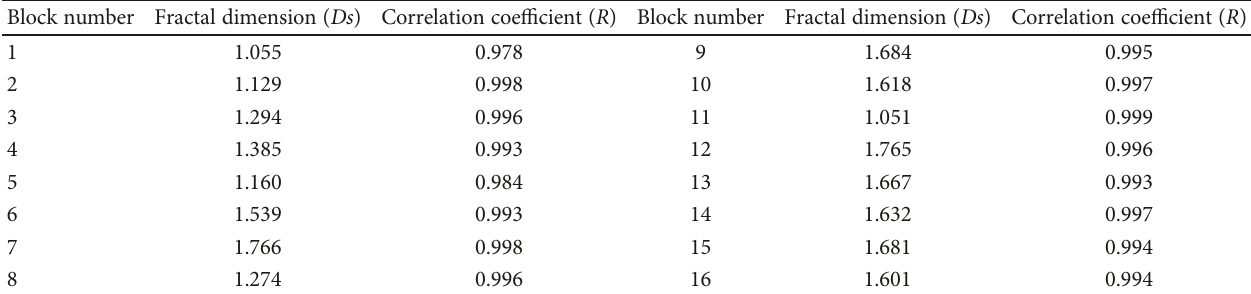
Figure 2: Grid partition diagram for fractal evaluation of the faults in the No. 13 Mine. Table 1: Fractal dimension and the correlation coe ffi cient of each